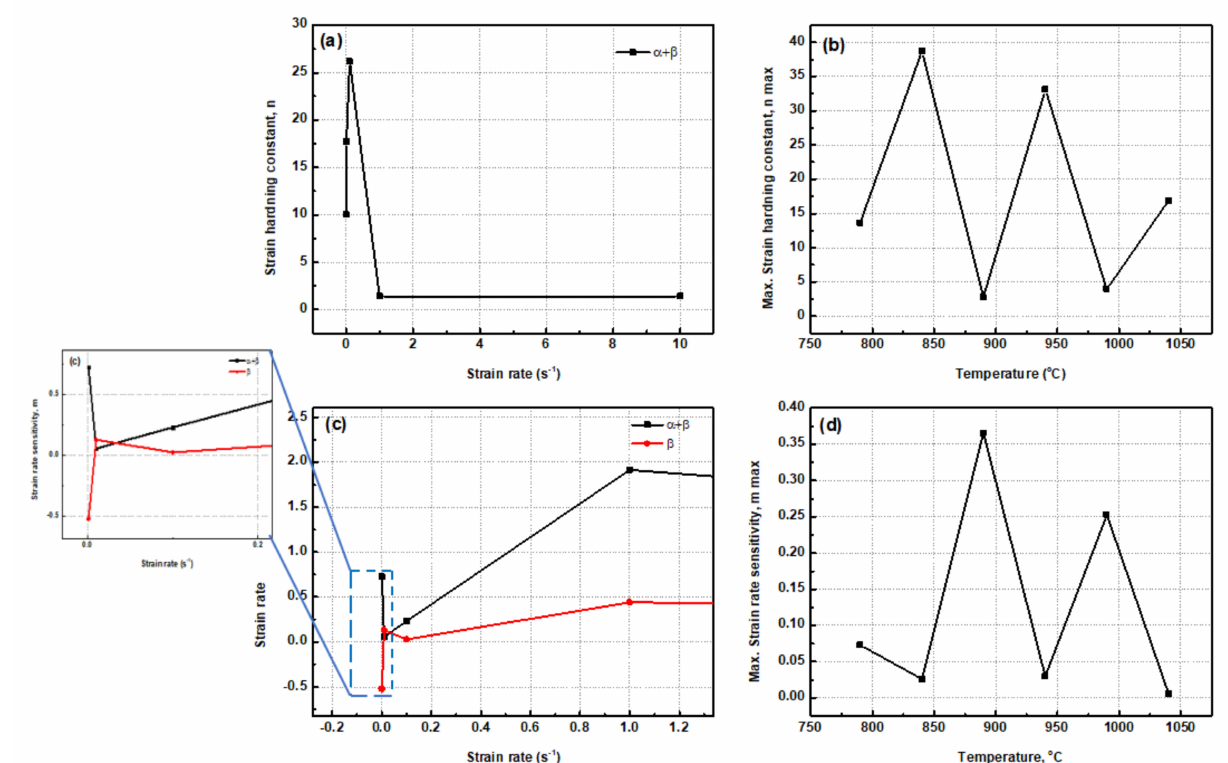
Figure 6. ( a ) Strain hardening constant (n) with change in strain rate (s − 1 ), ( b ) maximum strain hardening constant with temperature, ( c ) strain rate sensitivity (m) with strain rate (s − 1 ), and ( d ) max- imum strain rate sensitivity constant with change in deformation temperature during deformation of Ti6Al4V-5Cu alloy in the strain rate range of 10 − 3 to 10 s − 1